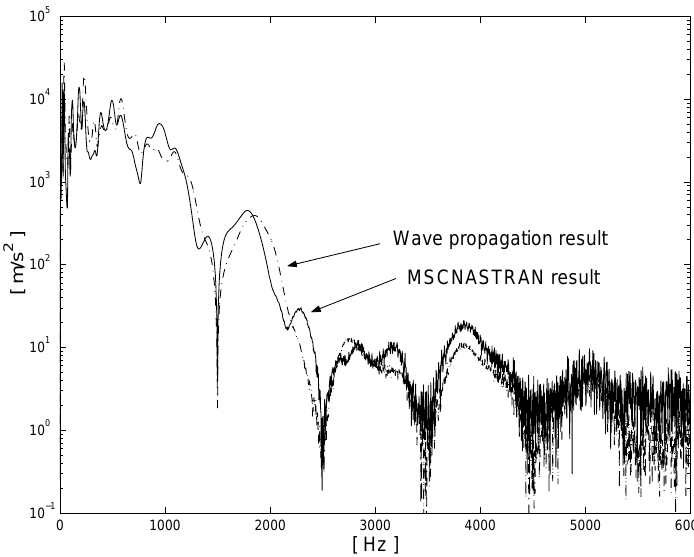
Fig. 9. Comparison between accelerations predicted by MSC-NASTRAN (continuous line) and by wave propagation analysis (dashed line) at the middle of plate no.5 of the two-dimensional structure. Material and geometric properties are: Young’s Modulus E = 7 . 3 × 10 10 N/m 2 , density ρ = 2700 kg/m 3